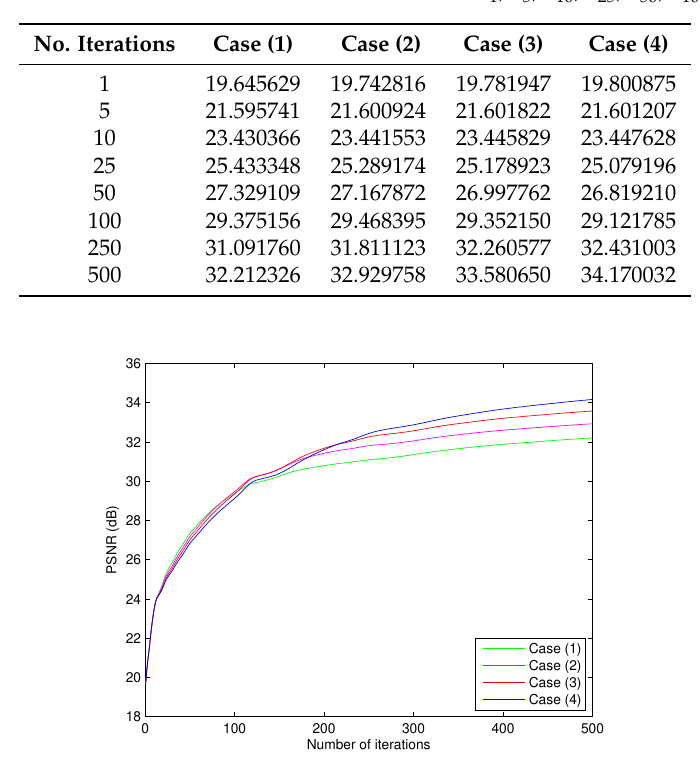
Figure 2. Comparison of four cases in Theorem